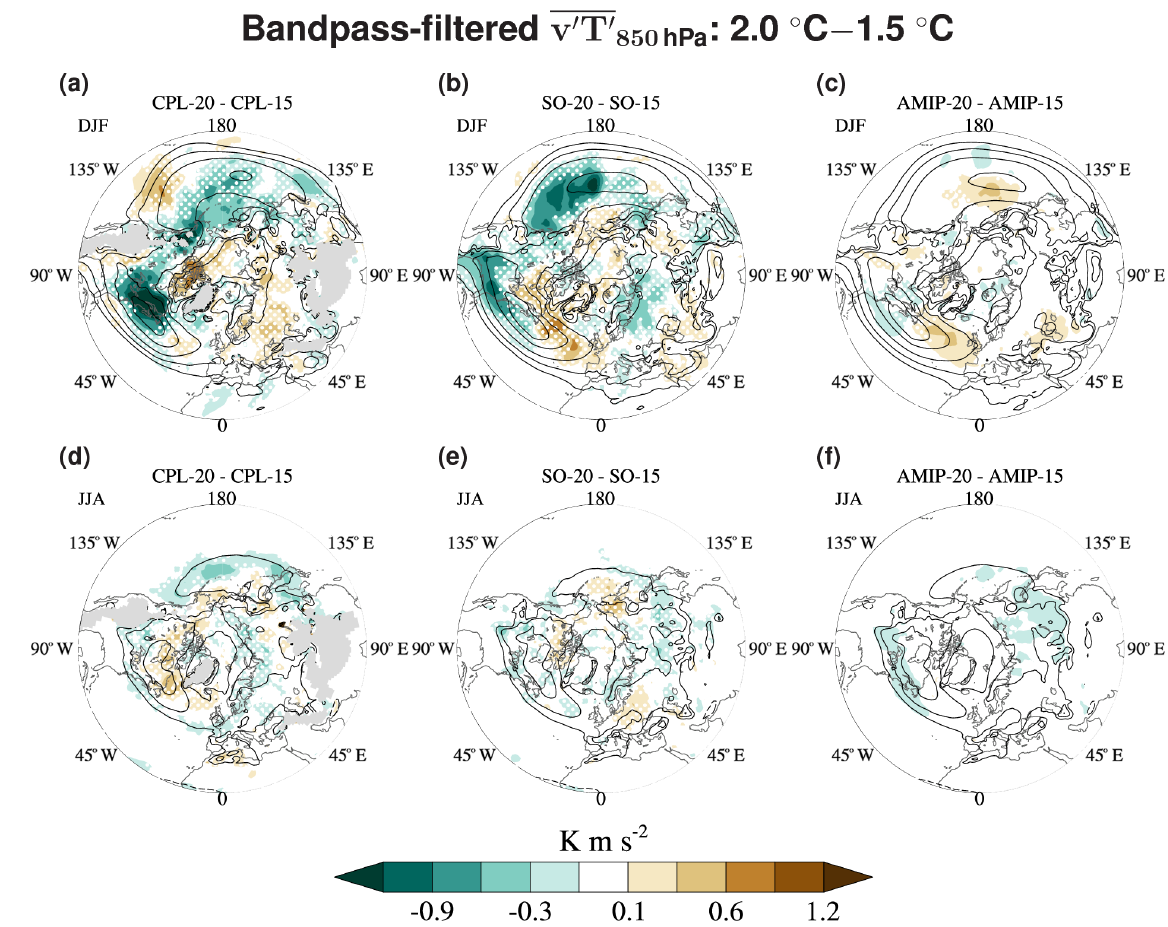
Figure 16. As in Fig. 15 but for the low-level storm-track response to the additional 0.5 ◦ C warming (i.e. the difference between the 2.0 and 1.5 ◦ C